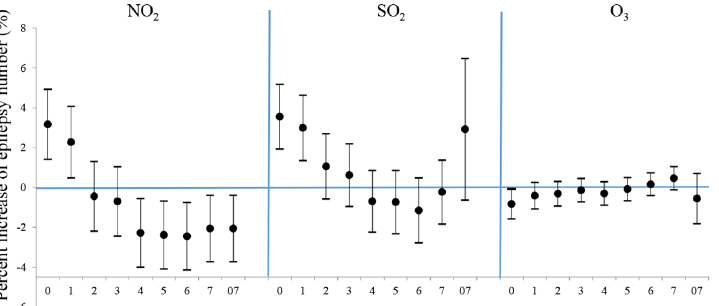
Fig 1. Percent increase in number of daily outpatient-visits for epilepsy associated with a 10- μ g/m 3 increase of air pollutants using different lag days in single-pollutant models. Values are reported as means and 95% confidence intervals. Abbreviations: Lag 07 day-moving average